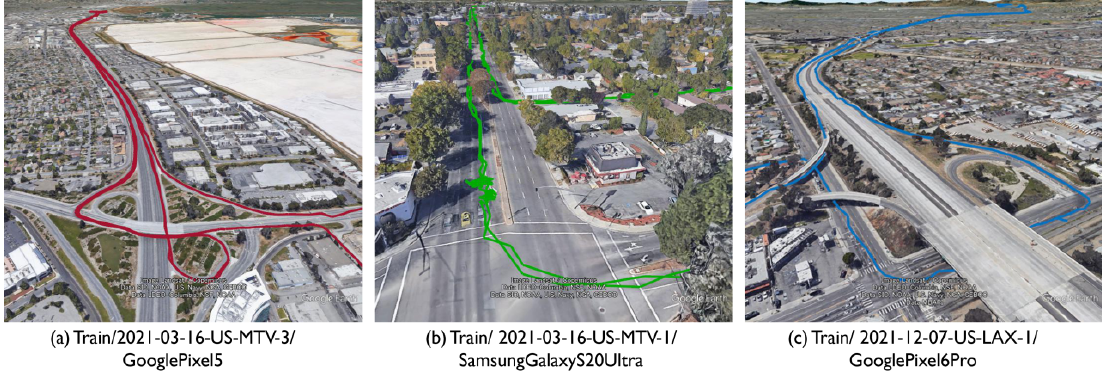
Figure 8. Driving trajectory of three vehicles extracted from the training dataset for evaluation ( a ) highway environment, ( b ) street driving, and ( c ) driving with GNSS blockage for a long period of time.